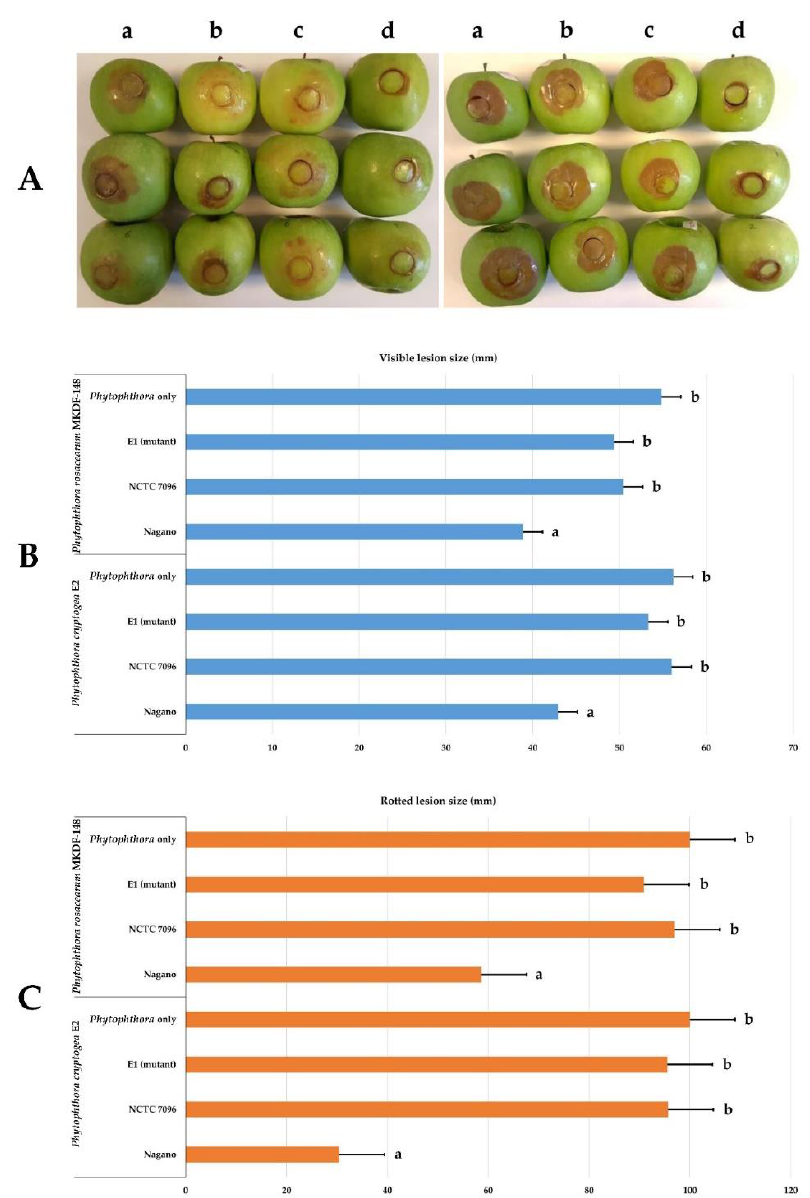
Figure 3. ( A ) Granny Smith apples inoculated with P. cryptogea (left side) and P. rosacearum (right side); (a) inoculated with P. cryptogea or P. rosacearum (positive control), (b) pre-treated with A. migulanus E1, (c) pre-treated with A. migulanus NCTC 7096, (d) pre-treated with A. migulanus Nagano (6 days after inoculation). ( B ) Effects of A. migulanus Nagano , NCTC 7096, and mutant E1 on lesion sizes in apples by Phytophthora cryptogea E2 and P. rosacearum MKDF-148 (6 days after inocula- tion). ( C ) Effects of A. migulanus Nagano , NCTC 7096, and mutant E1 on the amount of rot caused by Phytophthora cryptogea E2 and P. rosacearum MKDF-148 (6 days after inoculation). Bars labeled with